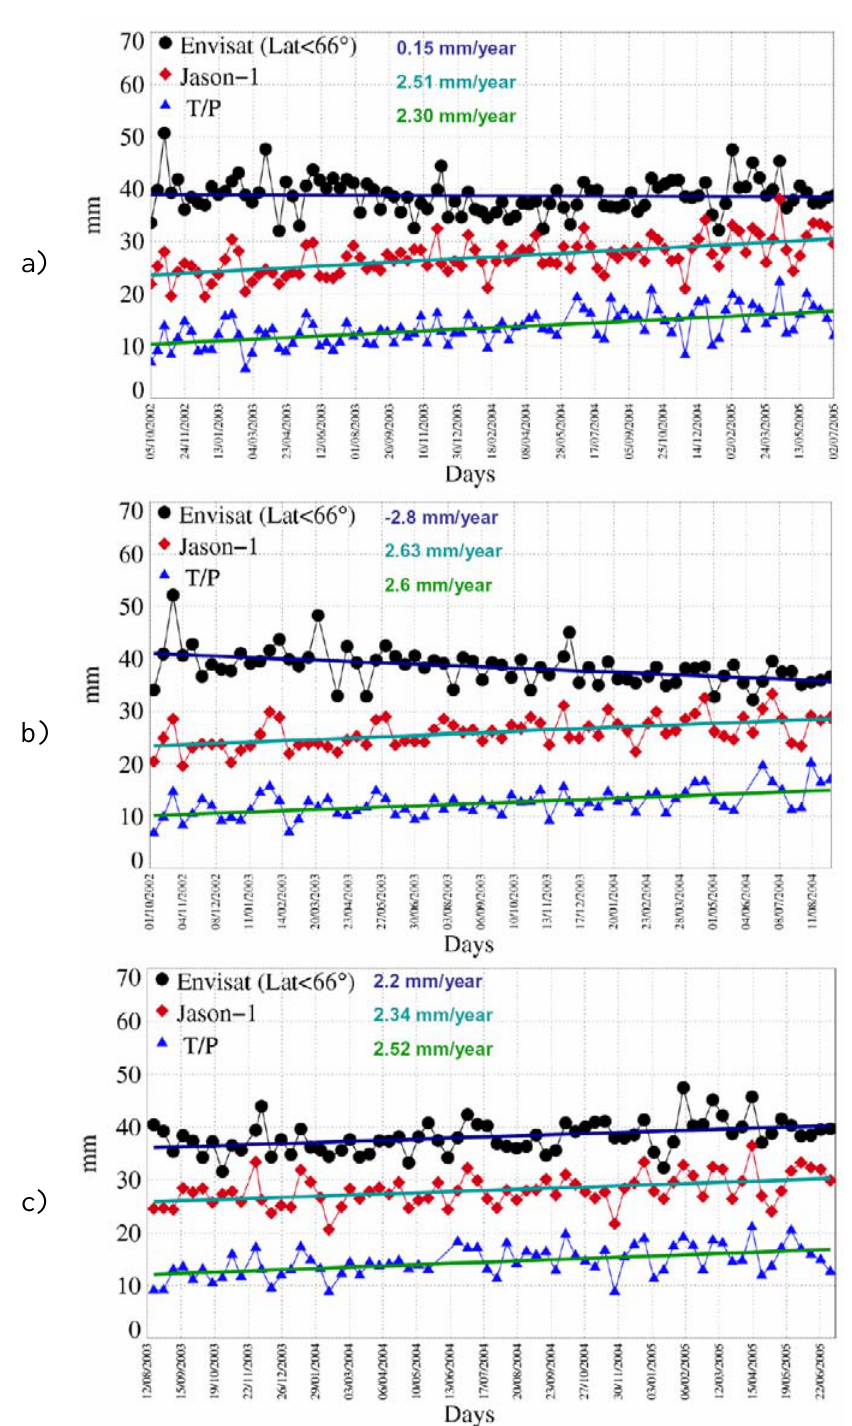
Figure 20: Envisat, Jason-1 and T/P global MSL trends a) over the whole Envisat mission, b) over the two first years of Envisat mission (cycle 10 to 29), c) over the two last years of Envisat mission (cycle 19 to